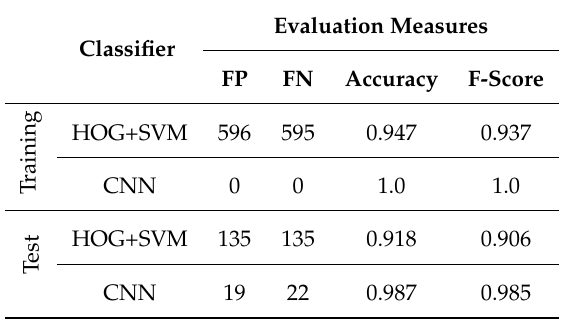
Table 3. Performance comparison of the CNN and HOG+SVM classifiers on the training and test datasets.